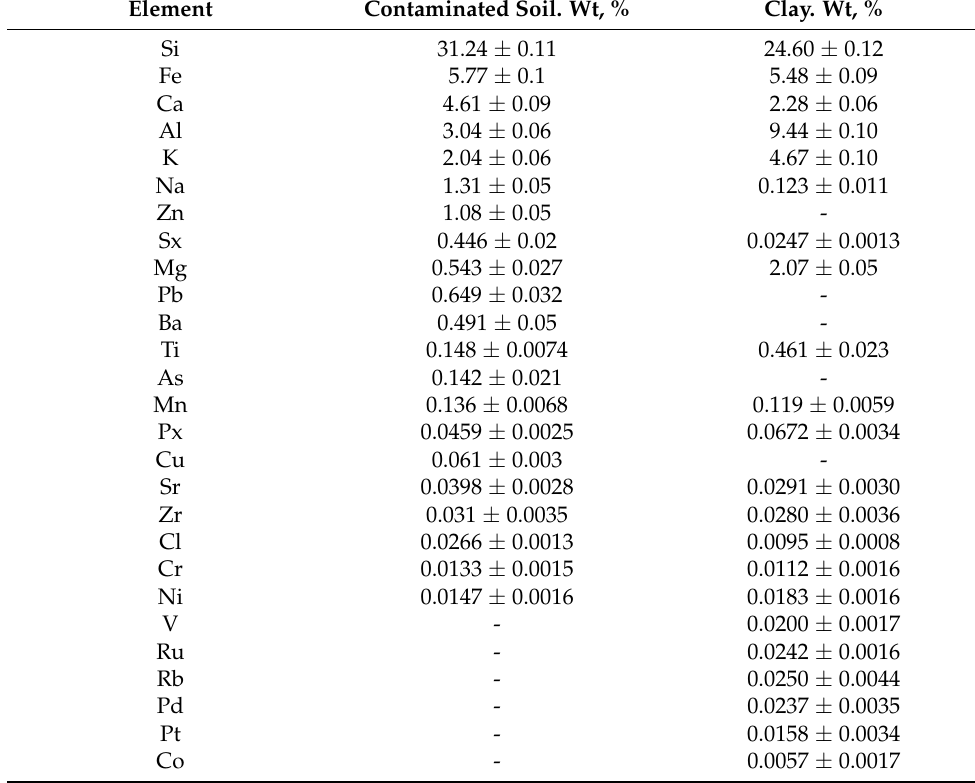
Table 6. X-ray fluorescence of the contaminated soil and clay.